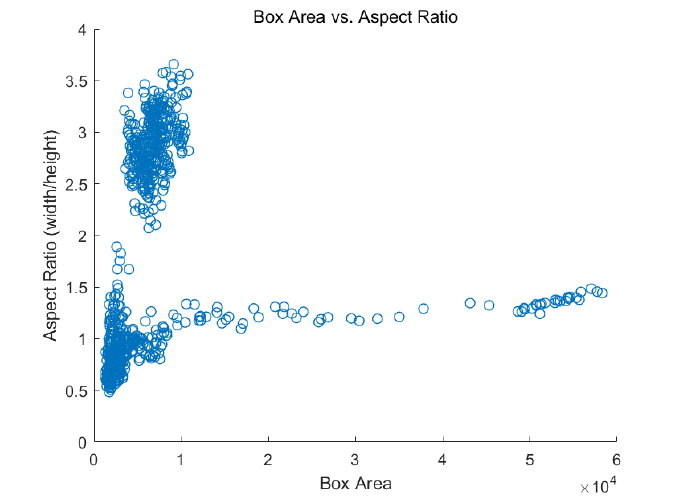
Figure 6. Aspect ratio and size of the ground-truth box of the dataset. The unit of the Box Area is